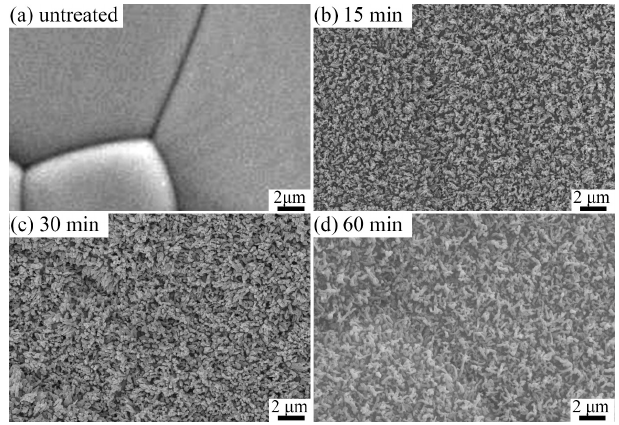
Figure 2. SEM micrographs of LSCF samples: ( a ) the fresh sample; and 800 °C for ( b ) 15 min, ( c ) 30 min, and ( d ) 60 min.